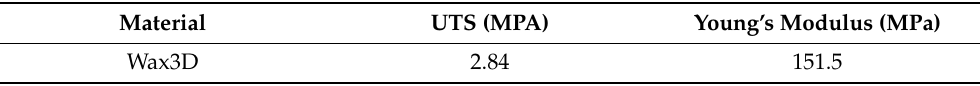
Table 9. The UTS and Young’s modulus for Wax3D